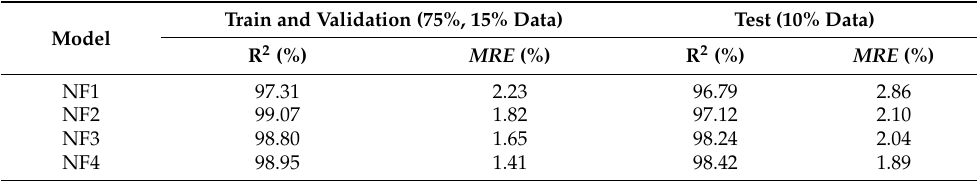
Table 5. The statistical indices for the Training and Validation, and the Test, subsets in the GP formulas.